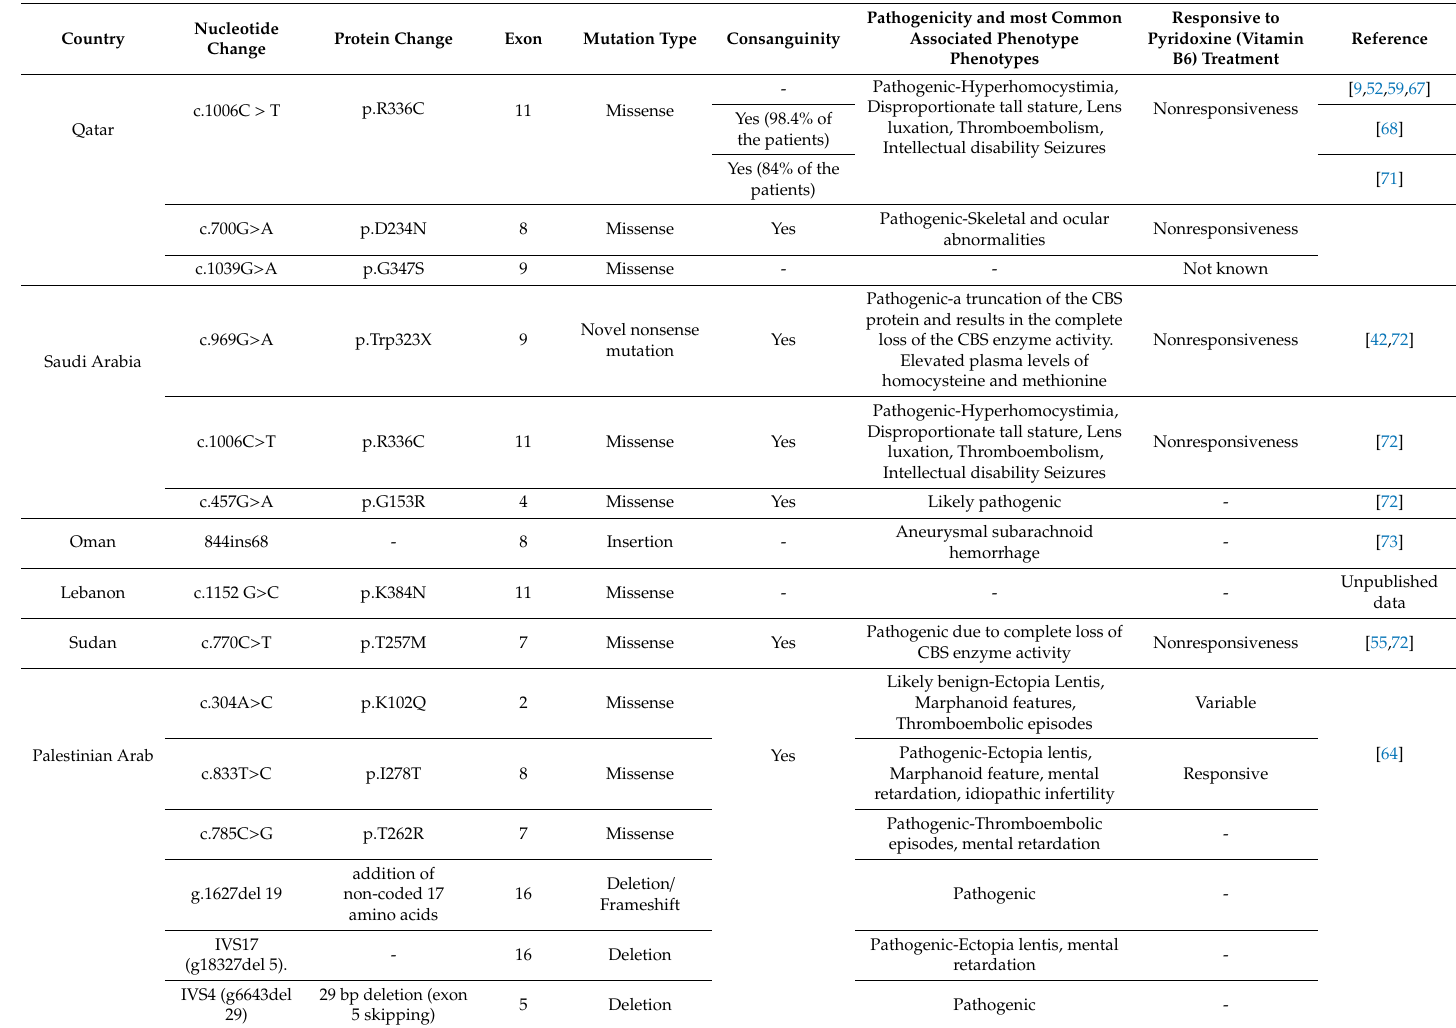
Table 2. CBS mutations and clinical phenotypes of homocystinuria in Arab